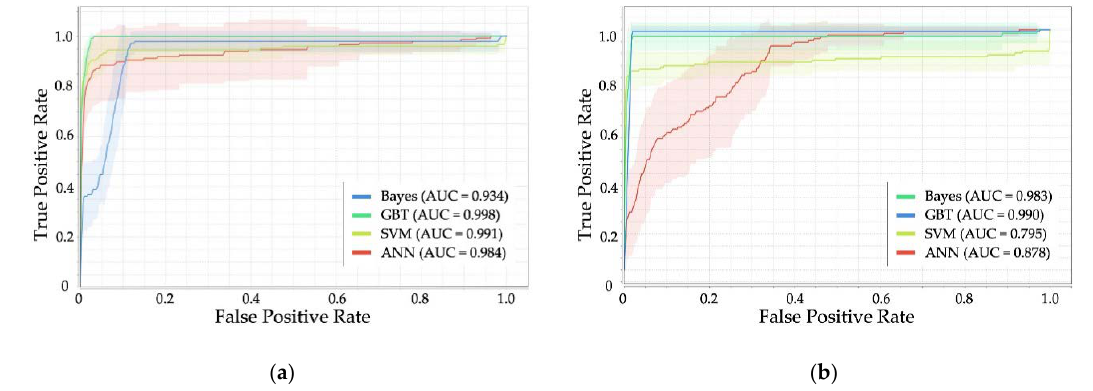
Figure 7. ROC curve for failure pipes: ( a ) Asbestos-cement pipes; ( b ) PVC pipes.